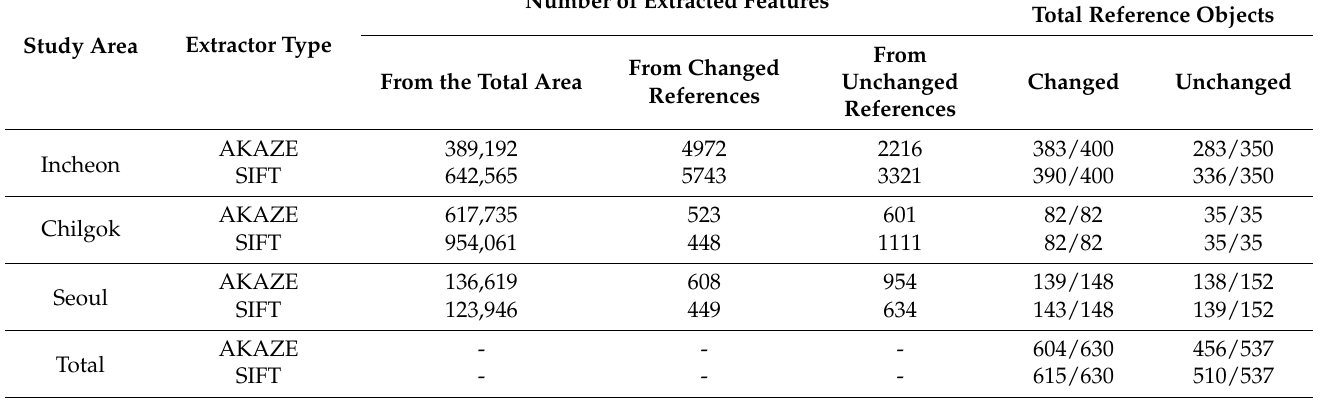
Table 3. Results of feature extraction.